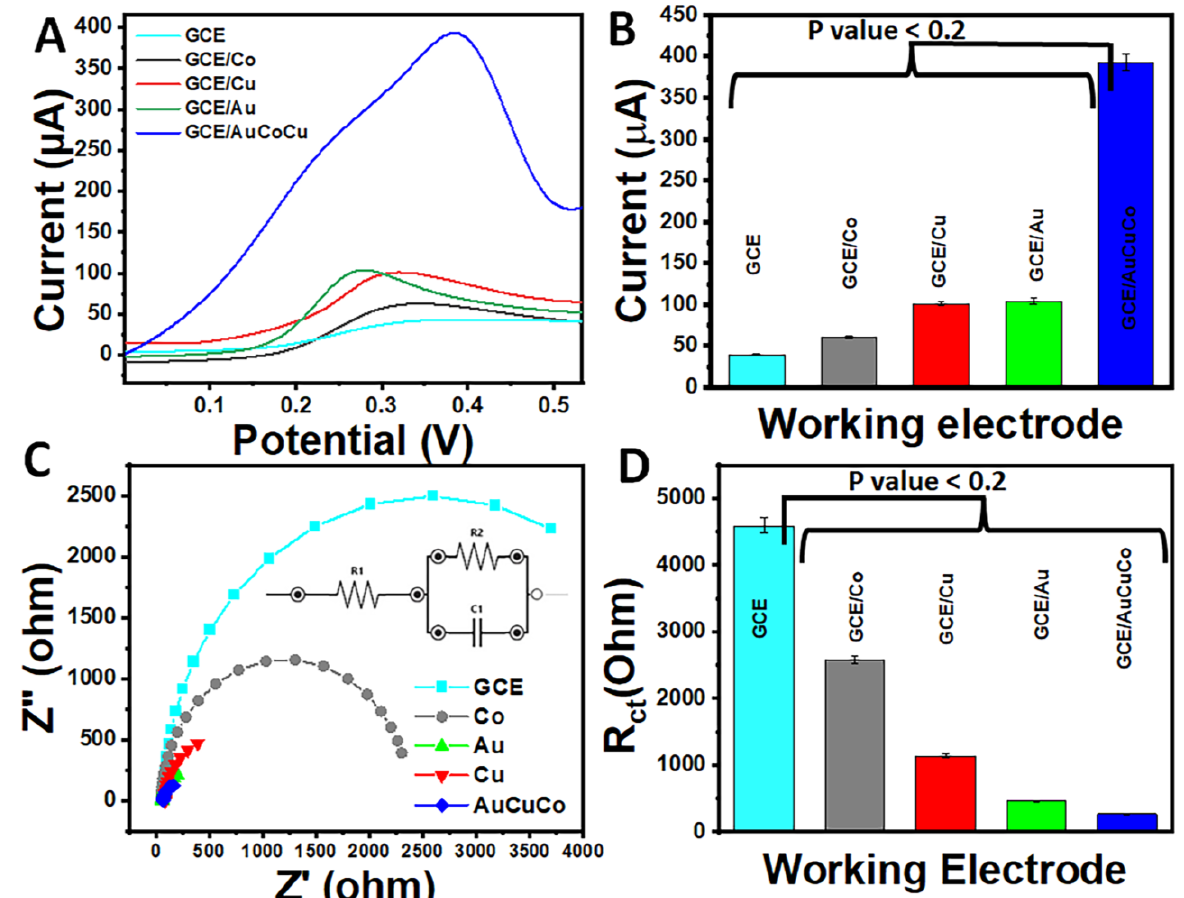
Figure 6. ( A ) LSV current signals of GCE (light blue curve), GCE/Co (grey curve), GCE/Cu (red curve), GCE/Au (green curve), and GCE/AuCoCu electrodes (blue curve) matrices in ZS (5 mM; pH-7, scan rate-100 mV/s); ( B ) Peak currents of electrode surfaces displayed in a comparative histogram; ( C ) EIS responses of GCE (light blue curve), GCE/Co (grey curve), GCE/Cu (red curve), GCE/Au (green curve), and GCE/AuCoCu electrode (blue curve) matrices with their circuit models; ( D ) Comparative histogram illustrating the corresponding Rct values.